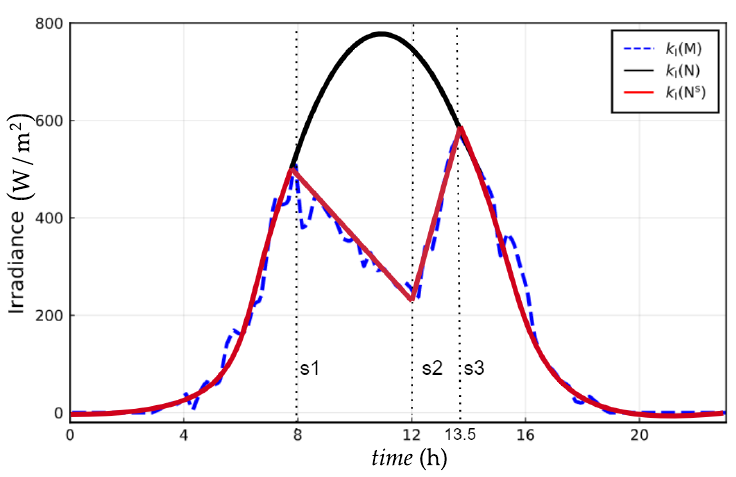
Figure 16. Solar irradiance fitted to normal distribution. Two shadow events (clouds) are considered between s 1 and s 2, and s 2 and s 3. k I ( M ) is the measured irradiance, k I ( N ) is the irradiance fitted with normal distribution, and k I ( N s ) is the irradiance with considering two shadow